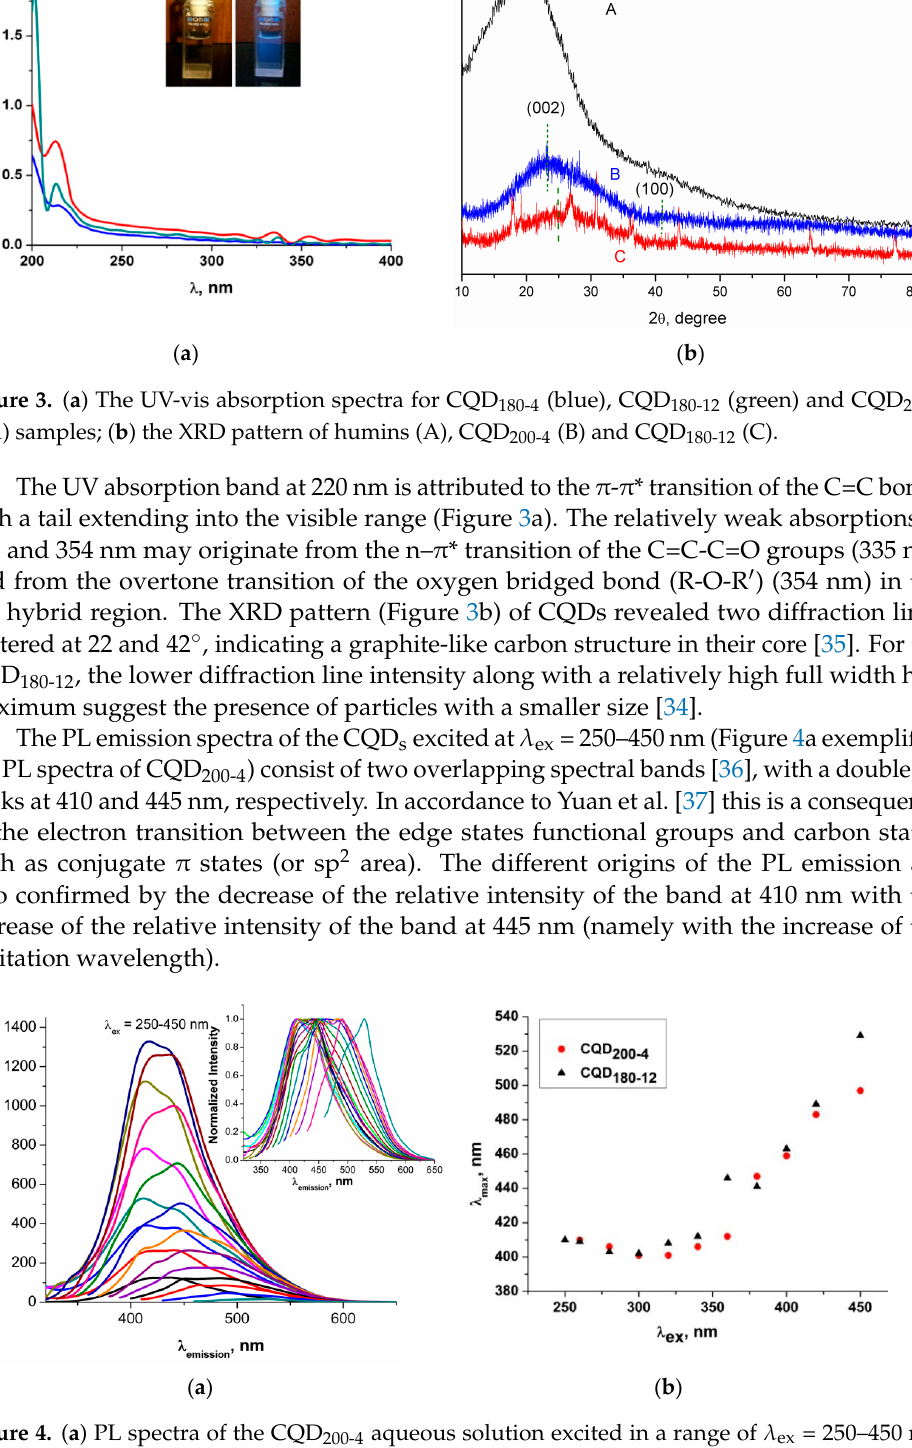
Figure 2. ATR-FTIR spectra in the 1000–4000 cm − 1 range of the CQDs synthesized at 200 ° C and 4 h and at 180 ° C and 12 h.